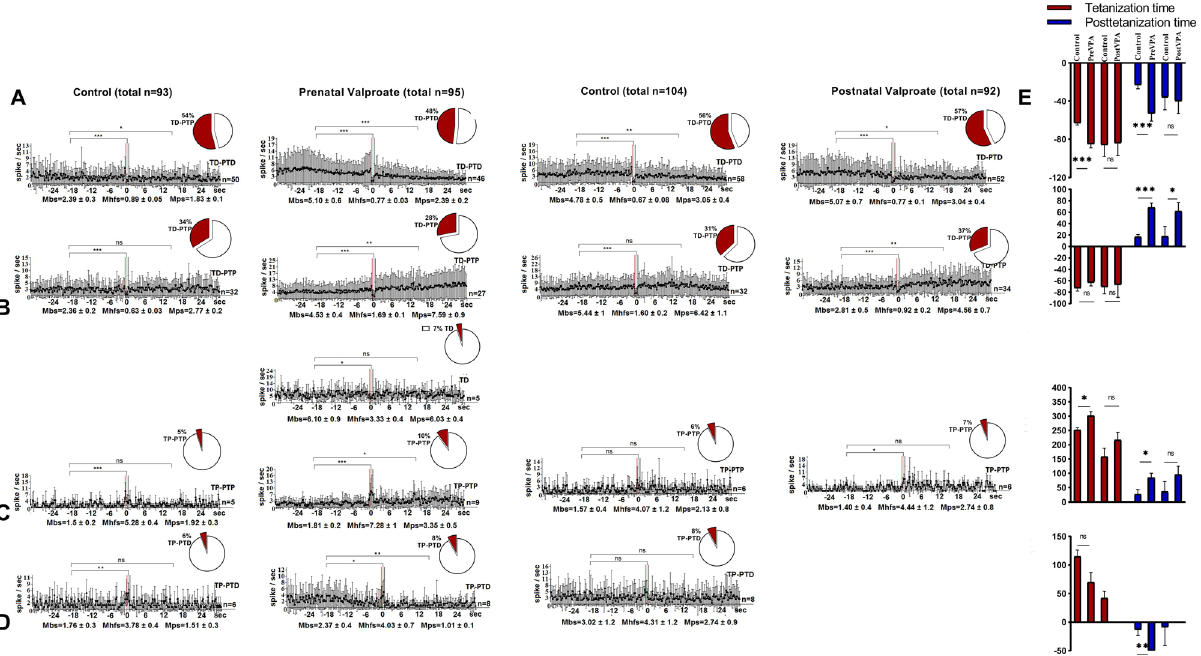
Figure 5. Electrophysiological changes in form of time histograms of peri-stimulus average spike frequency in neurons of prefrontal cortexto high-frequency stimulation of nucleus dentatusafter prenatal and postnatal VPA administration. The time histograms of peri-stimulus average spike frequency in neurons of prefrontal cortex are illustrated in the figure. The mean peri-stimulus frequency diagrams built on the basis of pre-stimulus and post-stimulus manifestations of spike activity of single PFC neurons to high-frequency stimulation of nucleus dentatus of the cerebellum in a real time 30 s before stimulation (Mbs), 30 s post-stimulation (Mps) and during high-frequency stimulation (Mhfs), exhibiting the specified types of response: ( A ) TD-PTD, ( B ) TD-PTP, ( C ) TP-PTP, ( D ) TP-PTD, TD only in prenatally VPA treated group. The data are presented as mean ± SD; n = number of neurons. The statistical significance from baseline (Mbs) was estimated according to the unpaired Student’s t-test , *** p < 0.001, ** p < 0.01, * p < 0.05, ns -non significant. ( E ) The bar diagrams show the average % change relative to the baseline (Mbs, zero level) in responses of tetanization time (red) and post-tetanization time (blue) in control vs. VPA treated groups in the population of neurons with a given type of response. Statistical significance was calculated using Fisher’s exact test, * p <